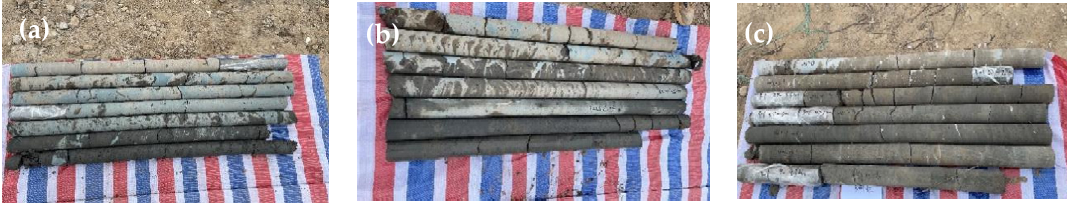
Figure 7. Influence of mixing times on the integrity of the mixing pile: ( a ) two times, ( b ) four times and ( c ) six times. Table 4. Influence of construction efficiency on oozing and integrity of the paste of a deep mixing pile. Mixing